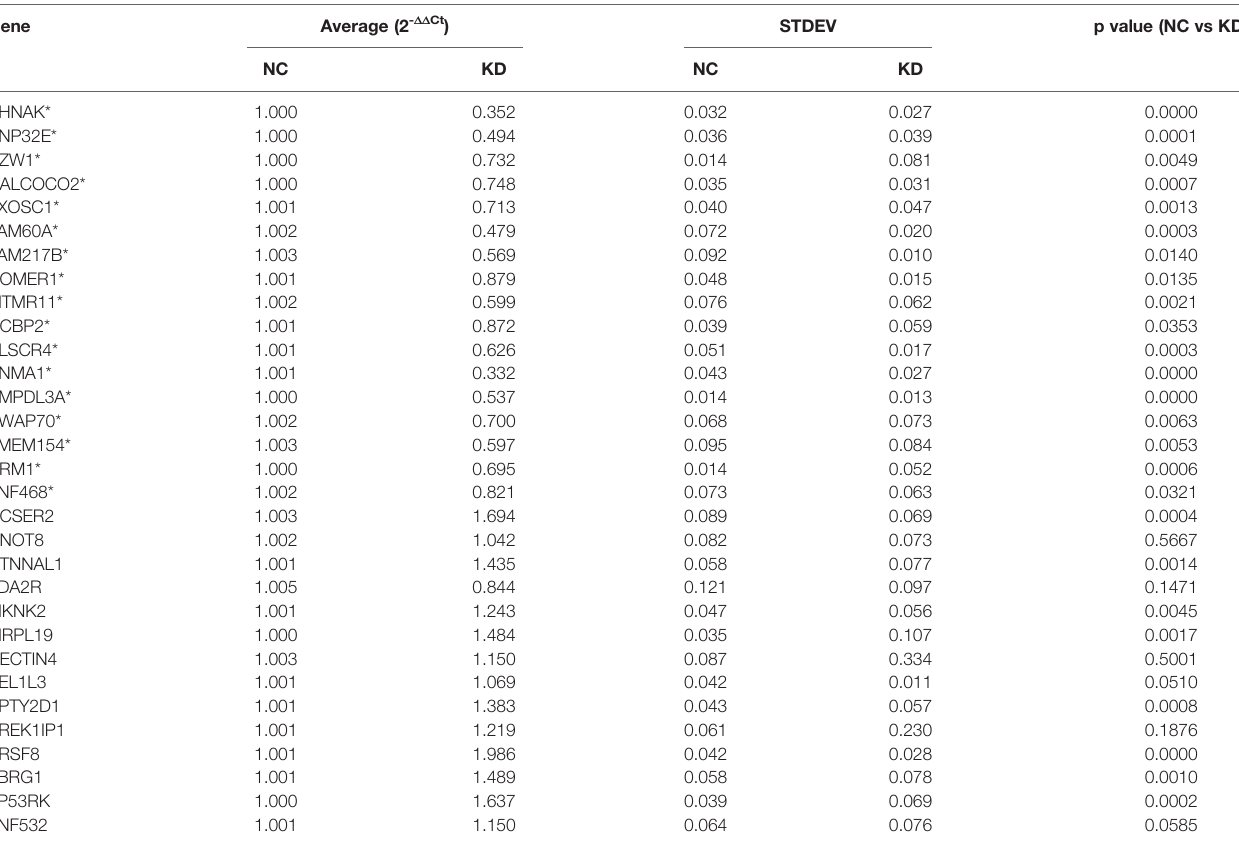
TABLE 3 | qPCR expression of representative differentially expressed